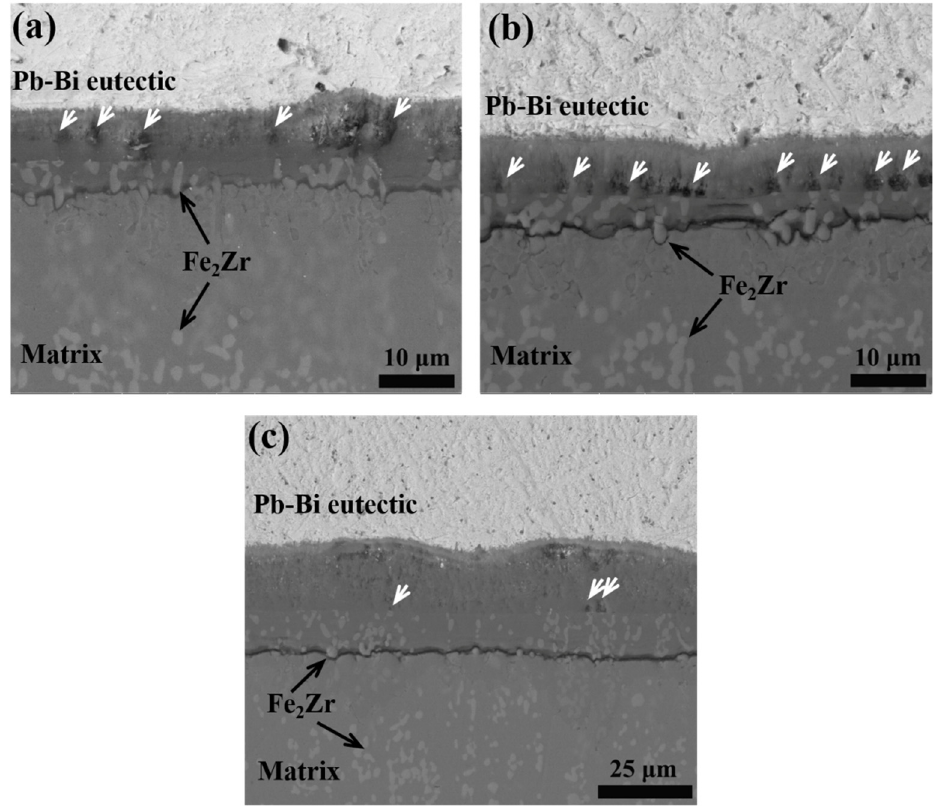
Figure 8. BSE images of cross-sectional morphologies of Fe-Cr-Zr alloy after exposure to oxygen- saturated Pb-Bi eutectic at 823 K for ( a ) 500 h, ( b ) 1000 h, and ( c ) 2000 h.